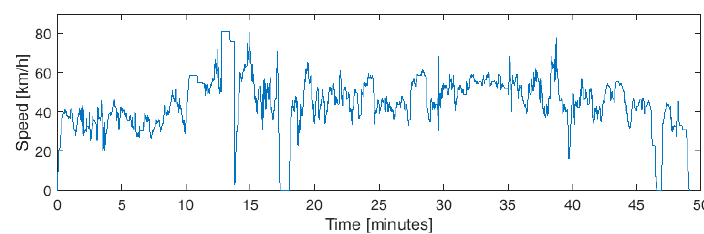
Figure 9. Extra-urban 1 speed profile.